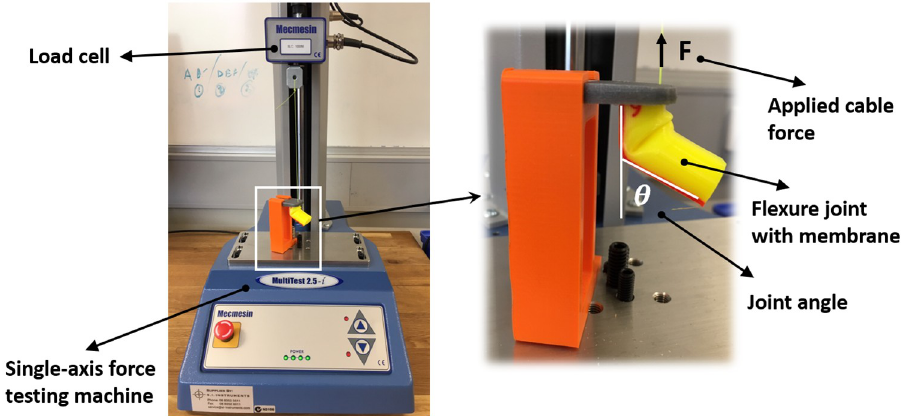
Fig 11. Experimental setup for measuring flexural